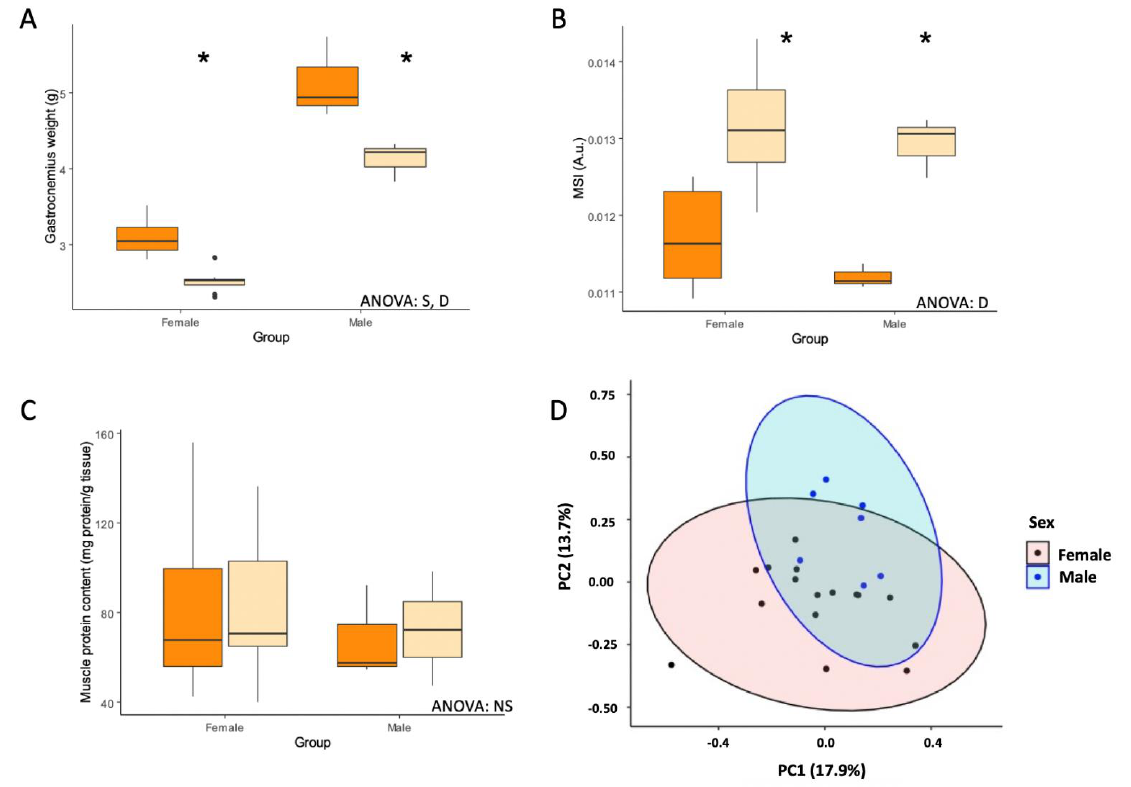
Figure 1. Effect of calorie restriction on skeletal muscle. Boxplots showing ( A ) gastrocnemius weight, ( B ) muscle somatic index (MSI), and ( C ) muscle protein content in female and male rats under ad libitum or calorie restriction diets. ( D ) Principal component analysis (PCA) plot performed on all data including weights, mRNA and protein expression (excluding mitochondrial complexes). The first component explains ~18% of the variation, and the second component ~15%. Two-way ANOVA was performed to assess for significance. Abbreviations: S, sex differences; D, diet differences; N, non-significant; PC1, principal component 1; PC2: principal component 2. * Significant difference between calorie-restricted and control